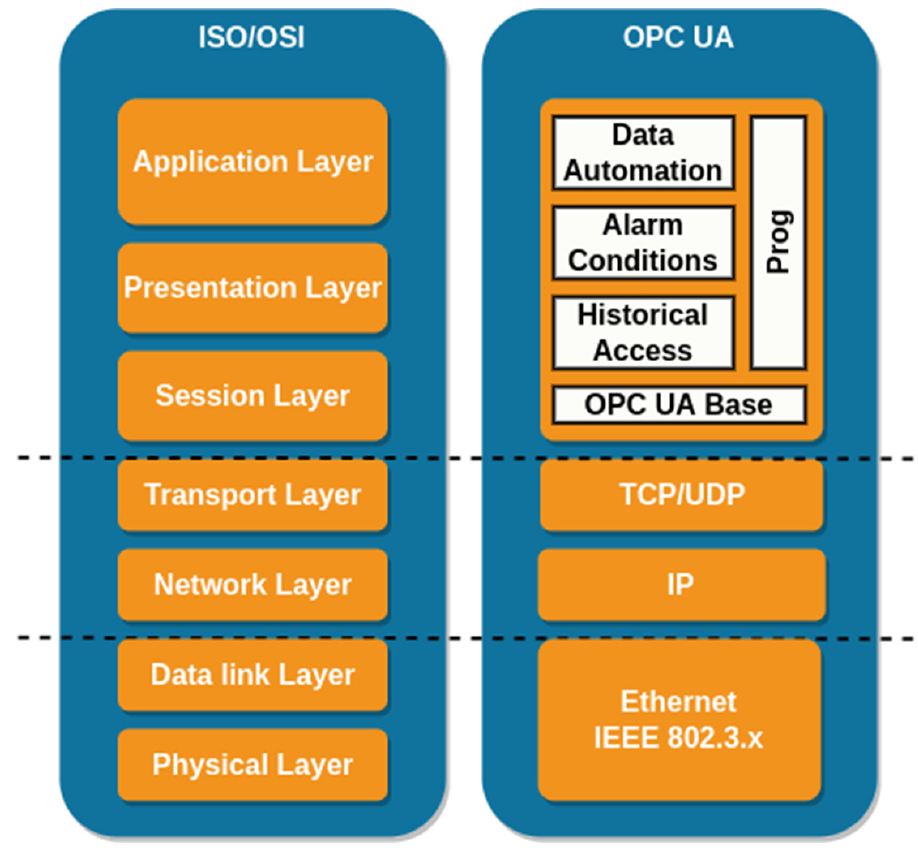
Figure 7. OPC-UA protocol in RM OSI model.